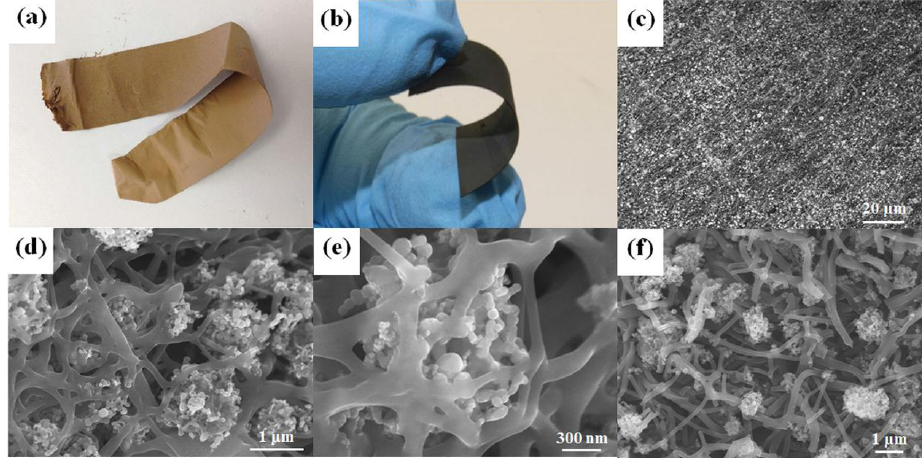
Figure 5. Photographs of the electrospun/sprayed flexible paper electrode ( a ) before and ( b ) after carbonization with 72 wt % Si; SEM images of the 3D Si/C fiber paper electrode: ( c – e ) top view and ( f )